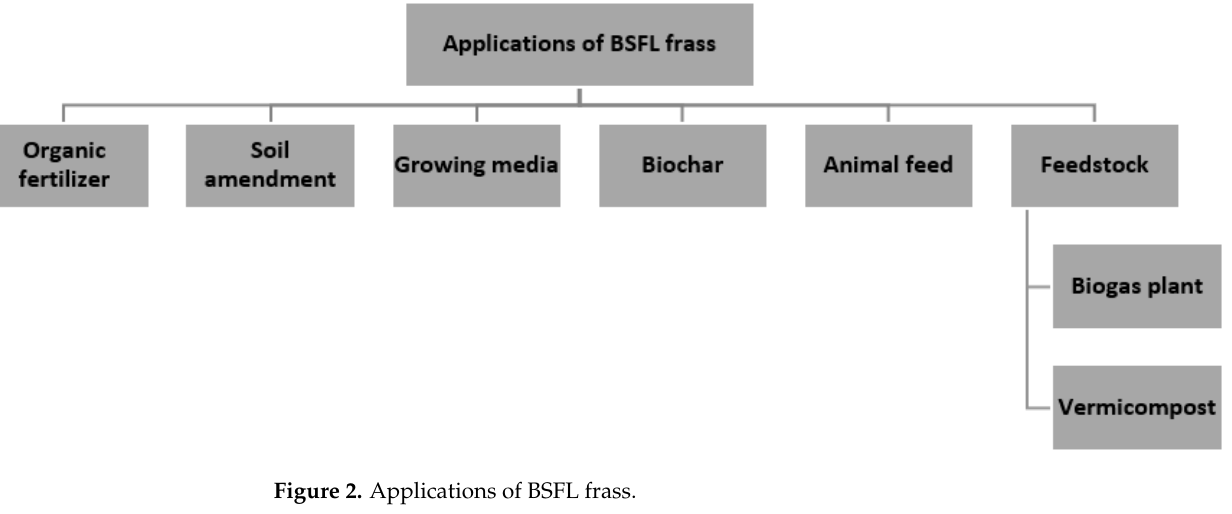
Figure 2. Applications of BSFL frass.